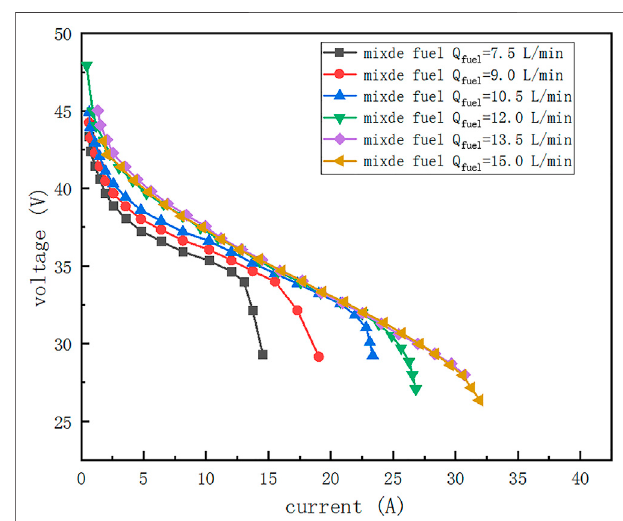
FIGURE 2 | Voltage-current characteristic curve of PEMFC under different crude hydrogen fl ow